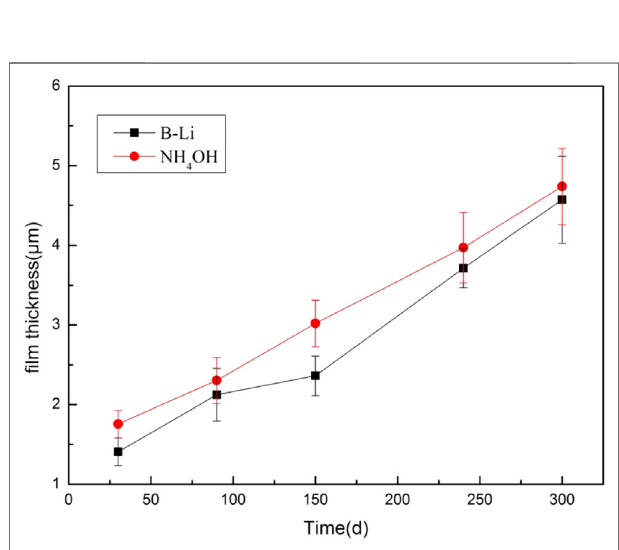
FIGURE 4 | Thickness change of the oxide fi lms tested in two types of solutions.